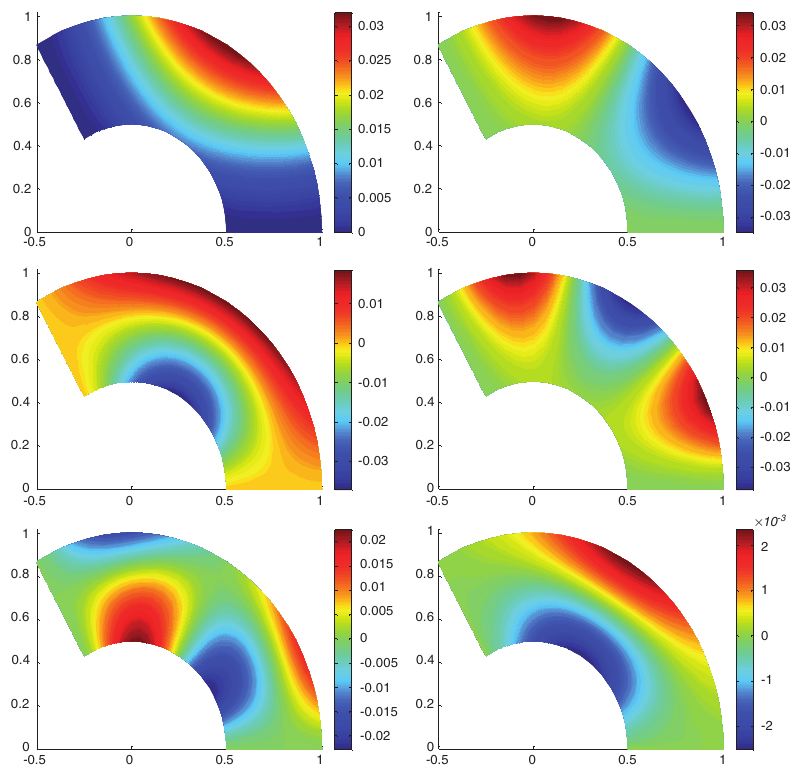
Figure 7 The first six mode shapes of an isotropic FG annular sector plate clamped at the radial edges for n = 1 and θ = 120 ° .